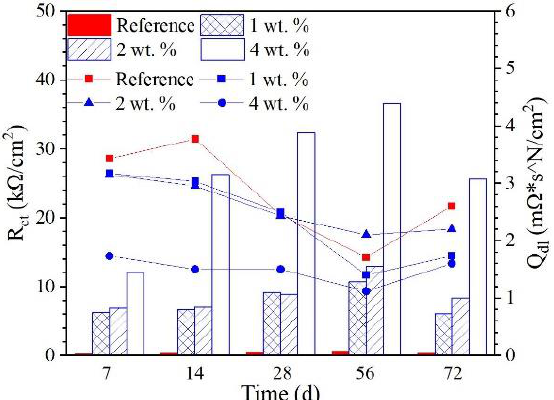
Figure 11. The fitted R ct and Q dl of the reinforcement embedded in concrete immersed in 3.5 wt. % NaCl solution at different ages.